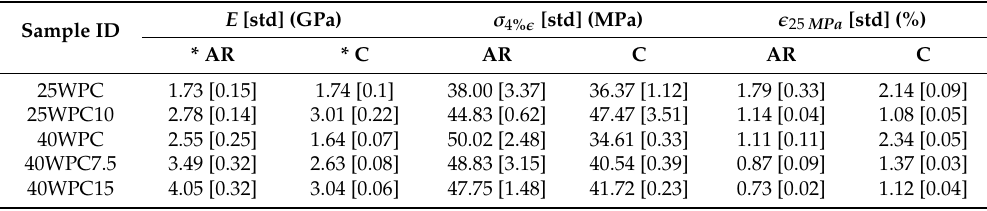
Table 6. Flexural properties of WPC with moisture e ff ect. The values 4% of strain and 25 MPa stress in subscript are selected as a common value to facilitate comparison between all